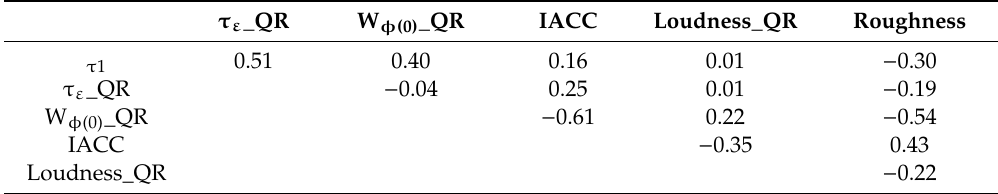
Table 2. The correlation coe ffi cients between the explanatory variables used in the multiple regression analysis in the equal loudness condition for the birdsongs.